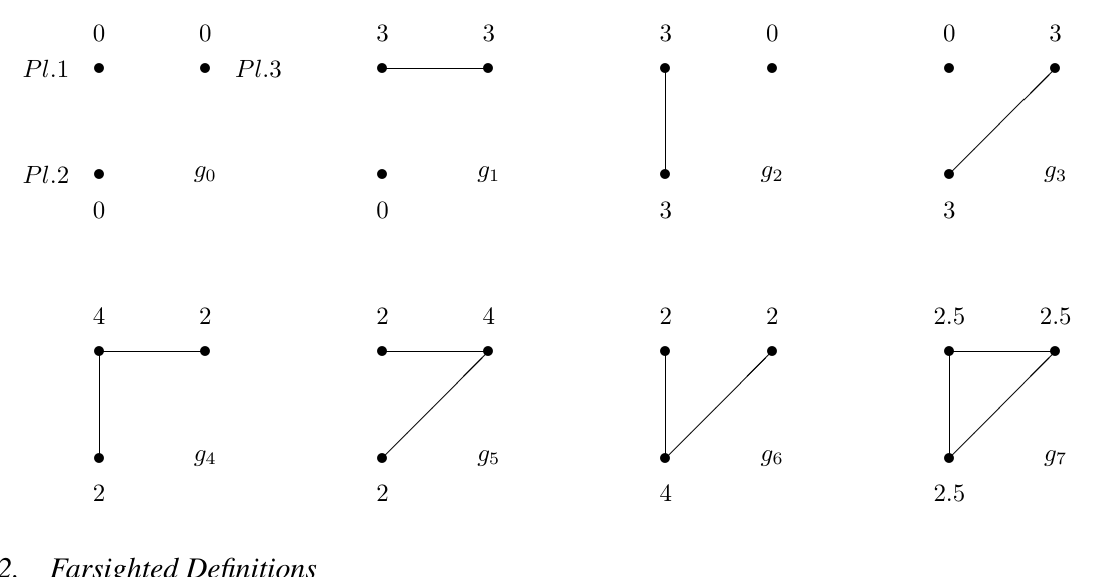
Figure 2. The co-author model with three